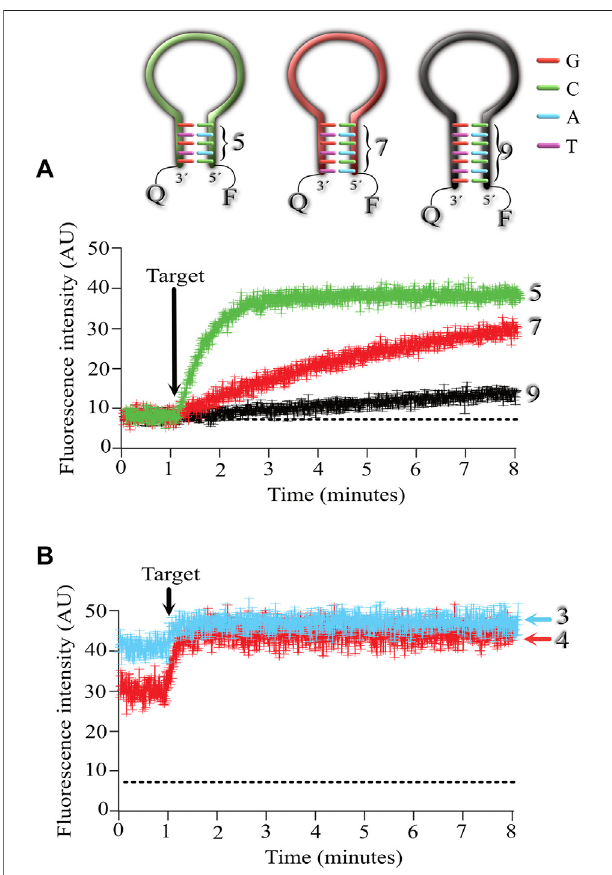
FIGURE 3 | Exploring the effect of the stem length on the association kinetics of the MB-target. Five MBs were synthesized with stem lengths of 3,4,5,7, and 9 nucleotides long. Fluorescence kinetics (Mean ± standard deviation) was measured from 6 independent microarrays, measuring the mean fl uorescence from at least 6 spots for each microarray. (A) , kinetics of MBs with stem lengths of 5 (green), 7 (red), and 9 (black) nucleotides. (B) , kinetics of MBs with stem lengths of 3 and 4 nucleotides. Notice that using 3 (light blue) and 4 (red) nucleotides in the stem results in higher background fl uorescence (baseline level). Arrow indicates the time of target application to the microarrays.